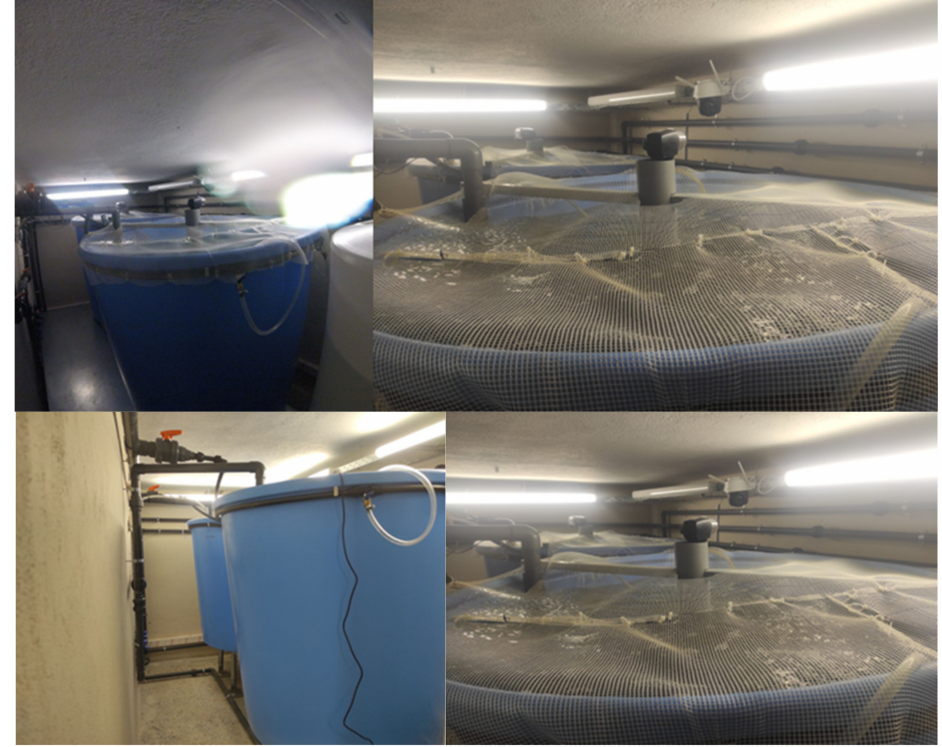
Figure 6. Round plastic tanks covered by a fish protection grid in an experimental research of rainbow trout aquaculture in an aquaponic system in